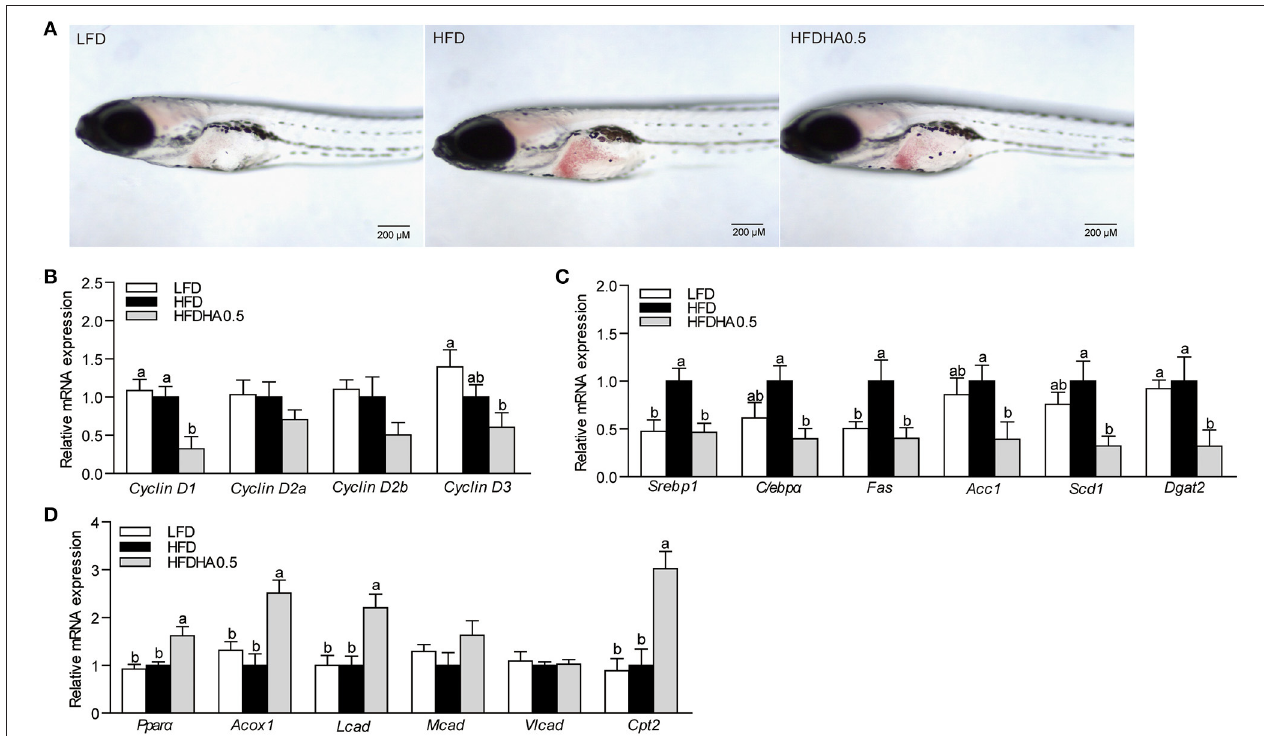
FIGURE 6 | Effects of DHA supplementation on lipid metabolism in GF zebrafish. (A) Whole-mount oil red staining in GF zebrafish fed LFD, HFD and HFDHA0.5. The scale bar is 200 µ m. (B) Relative mRNA expression of CyclinDs. Relative mRNA expression of (C) lipid synthesis-related, and (D) lipid β -oxidation-related genes. Values are means ± SEMs ( n = 4 biological replicates). Means without a common letter are significantly different, P <